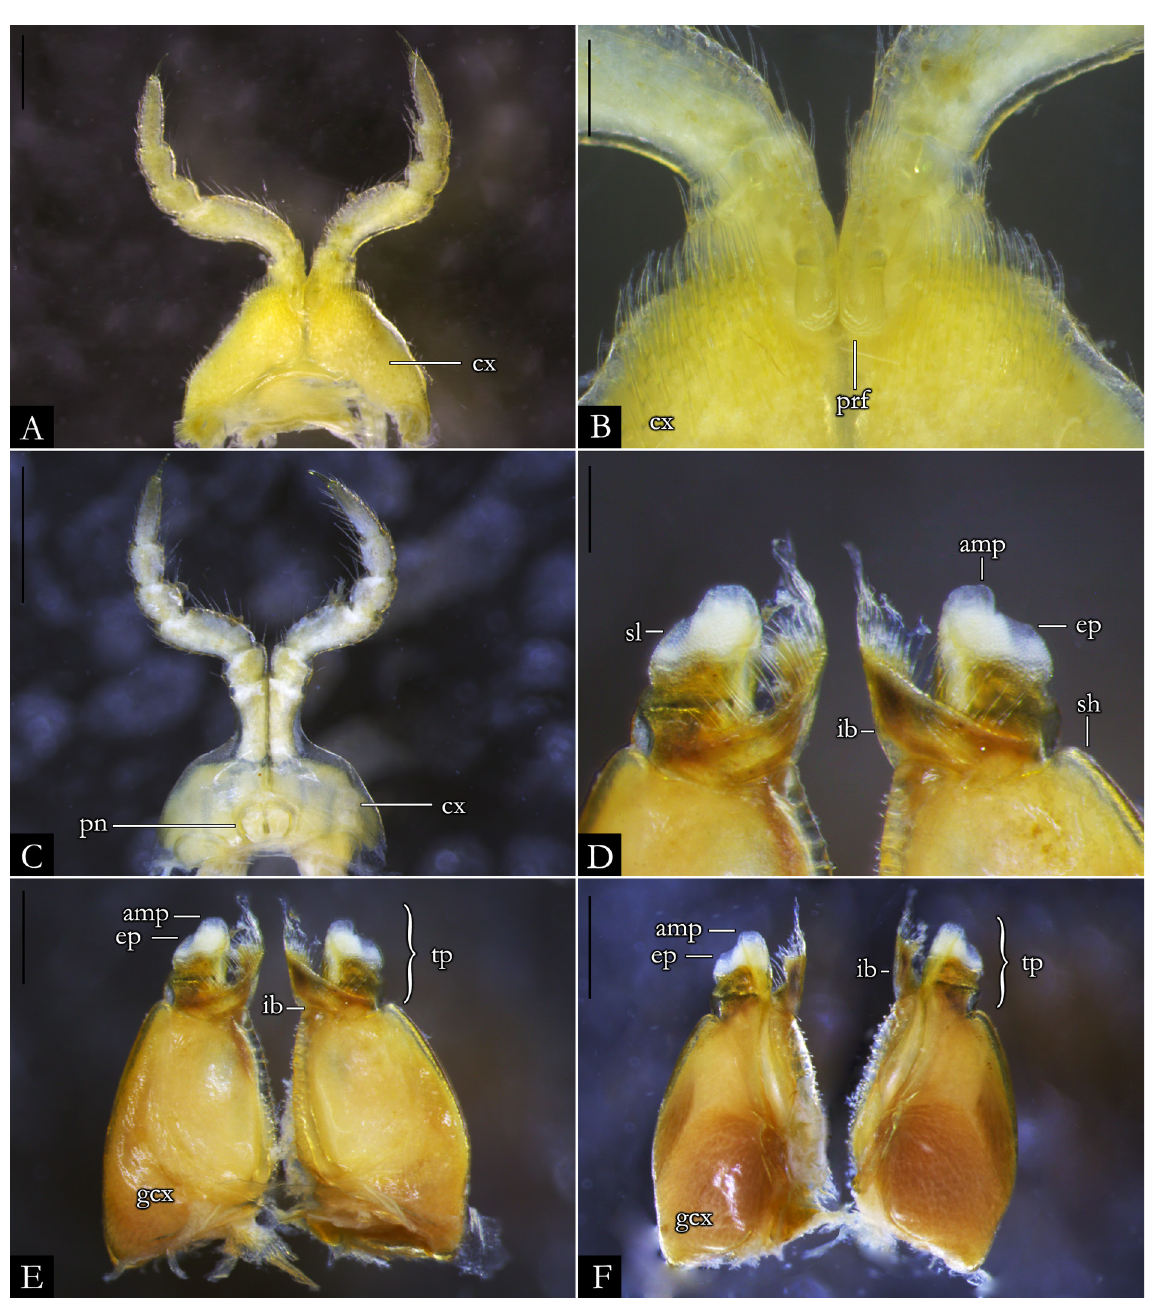
Fig. 126. Pseudonannolene silvestris Schubart, 1944, ♂ (IBSP 2271). A . First leg-pair. B . Detail of prefemur. C . Second leg-pair. D . Detail of telopodites, in anal view. E . Gonopods, in anal view. F . Gonopods, in oral view. Abbreviations: see Material and methods. Scale bars: A, C, E–F = 0.5 mm; B, D = 0.2